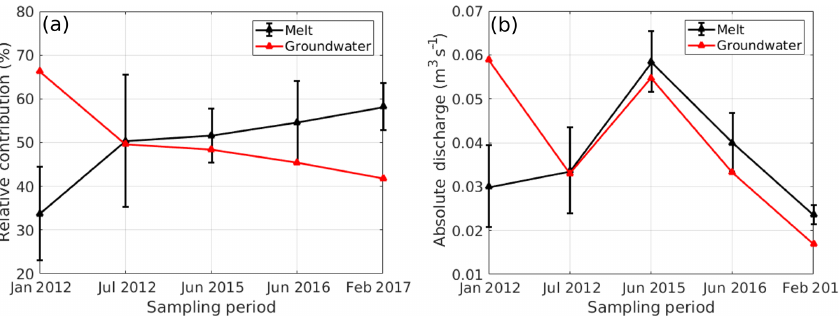
Figure 4. The HBCM mixing model predicts a range in relative surficial meltwater contributions to discharge over five discrete sampling times, which may reflect both temporal changes and uncertainties. Error bars bracket HBCM estimates that produced similar best matches to observed tracer concentrations; however, actual uncertainties are higher because of residual errors. Absolute meltwater discharge contribu- tions can vary in time very differently than relative inputs, in part due to varying groundwater